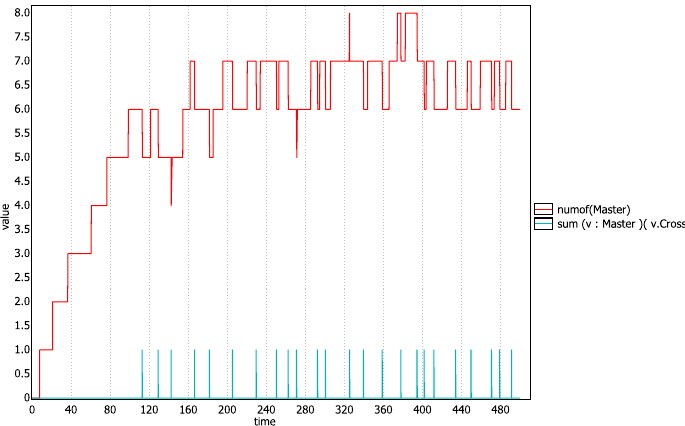
Figure 9. Number of active templates at any given time and templates getting